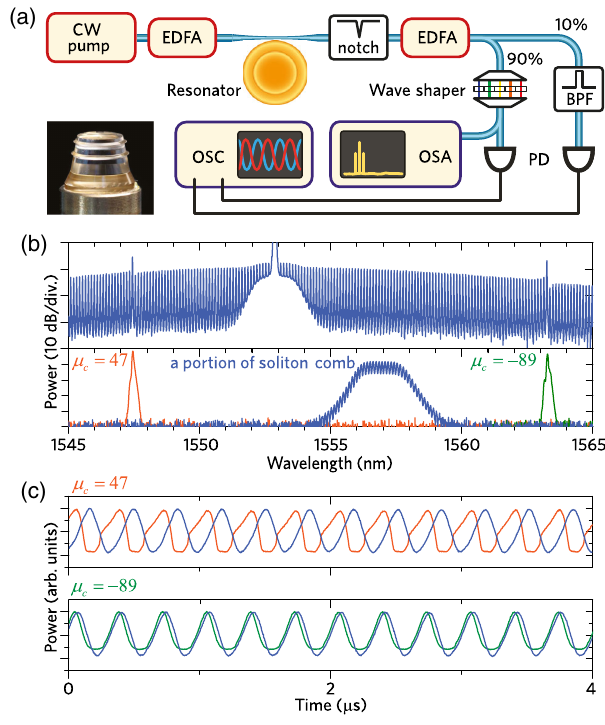
FIG. 4. Observationofperiodic energyexchangeinanintermode breather soliton state. (a) Schematic of the experimental setup. EDFA, erbium-doped fiber amplifier; BPF, bandpass filter; PD, photodetector; OSC, oscilloscope; OSA, optical spectral analyzer. (b) Generated single-soliton-based frequency comb in the MgF 2 microresonator (upper) and filtered components (lower) by using a wave shaper and by a bandpass filter. (c) Recorded fast power ¼ 47 (red) and μ ¼ evolution of a single filtered comb mode, μ c c − 89 (green) compared to a “ regular ” filtered portion of the soliton ¼ 47 shows an out-of-phase spectrum (blue line). The power in μ c ¼ − 89 oscillation to the soliton (upper), while the power in μ c shows an in-phase oscillation